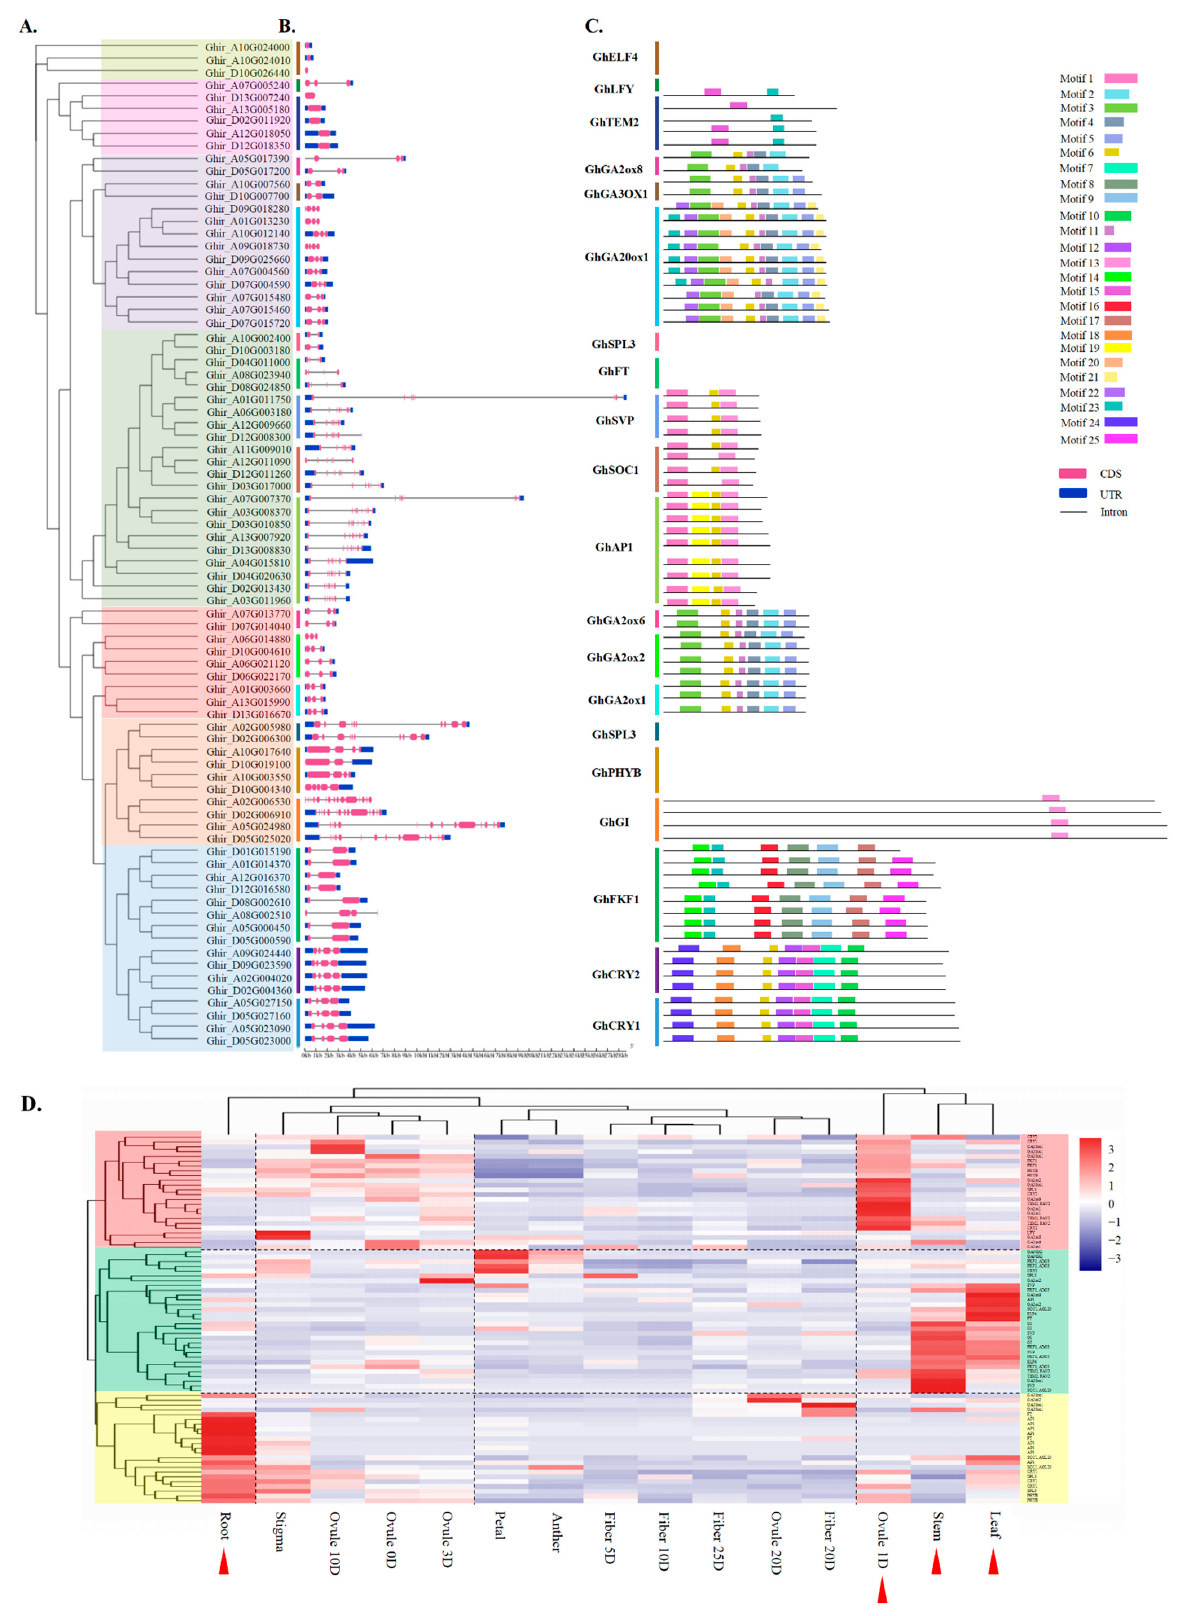
Figure 3. Distribution of the conserved motifs and exon–introns of photoperiod pathway flowering- related genes in G. hirsutum . ( A ) Phylogenetic tree of photoperiod pathway flowering-related